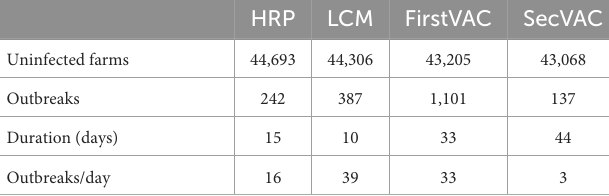
TABLE 3 Number of outbreaks and uninfected farms for each epidemic period in Uruguay in 2001, including its duration and the number of outbreaks per day.